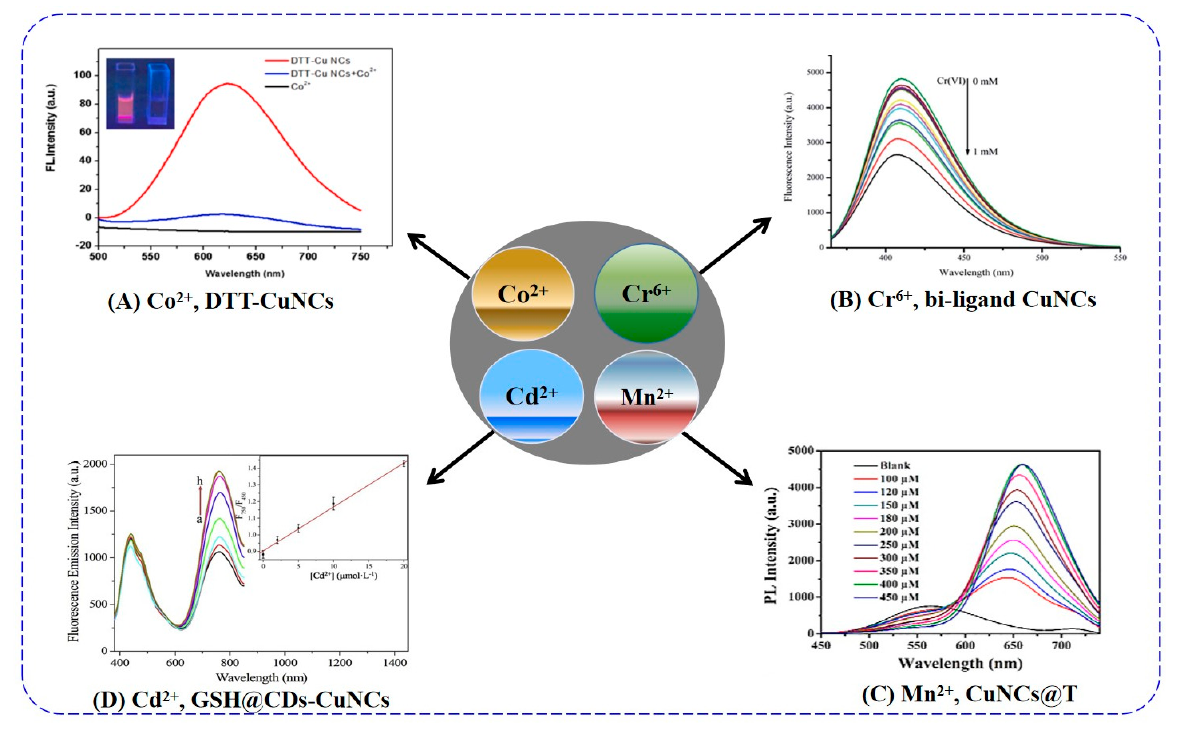
Figure 11. ( A ) Fluorescence spectra of DTT-CuNCs and with Co 2+ [71], Copyrights from Elsevier, 2021. Different concentrations of HMIs were added to ( B ) bi-ligand CuNCs [111], Copyrights from Royal Society Chemistry, 2019; ( C ) CuNCs@T [112], Copyrights from Royal Society Chemistry, 2017; and ( D ) GSH@CDs-CuNCs [113], Copyrights from Elsevier, 2020.